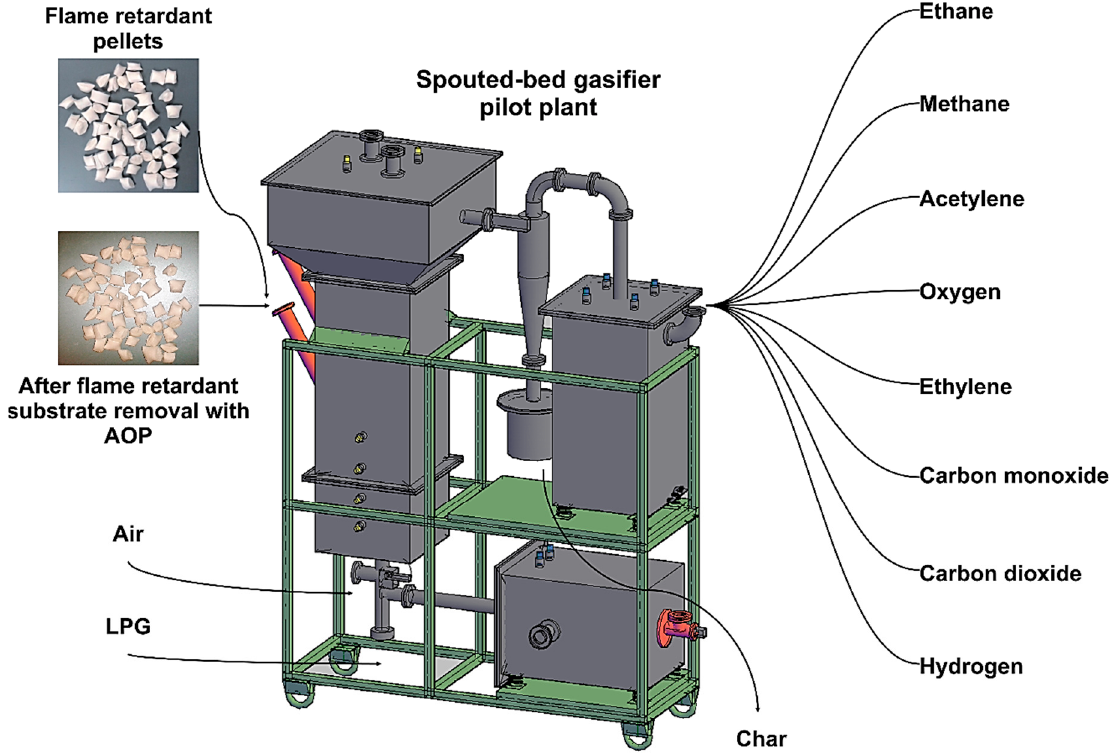
Figure 1. Schematic illustration of utilized spouted bed gasification plant and prepared pellets.